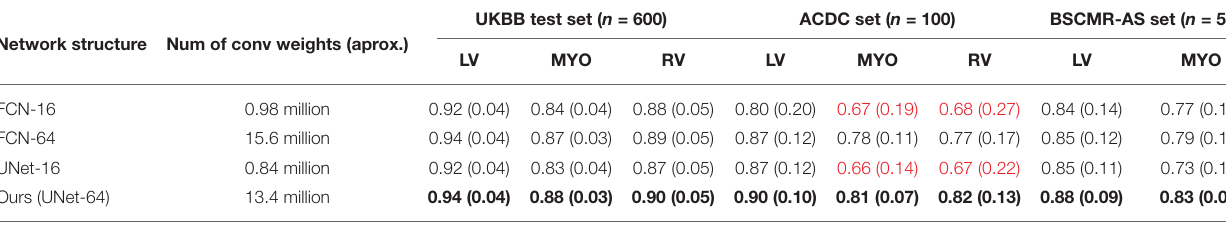
TABLE 4 | Cross-dataset segmentation performances of four different network architectures. UKBB test set ( n = 600) ACDC set ( n = 100) Network structure Num of conv weights (aprox.)